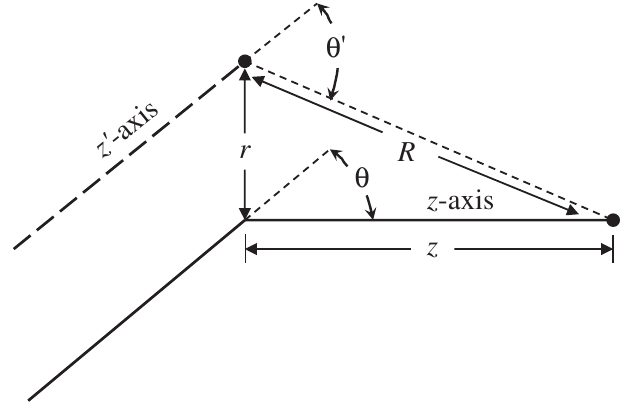
FIG. 6. After being deflected through an angle (cid:1) by a short magnet, the bunch travels parallel to the z axis. To calculate the wake contribution from an electron located at a distance r from the z axis, with azimuthal angle (cid:6) , let the z 0 axis describe its path upstream of the magnet. At distance z downstream of the magnet, a point on the z axis is at distance R from the point where the electron is deflected, at polar angle (cid:1) 0 with respect to the z 0